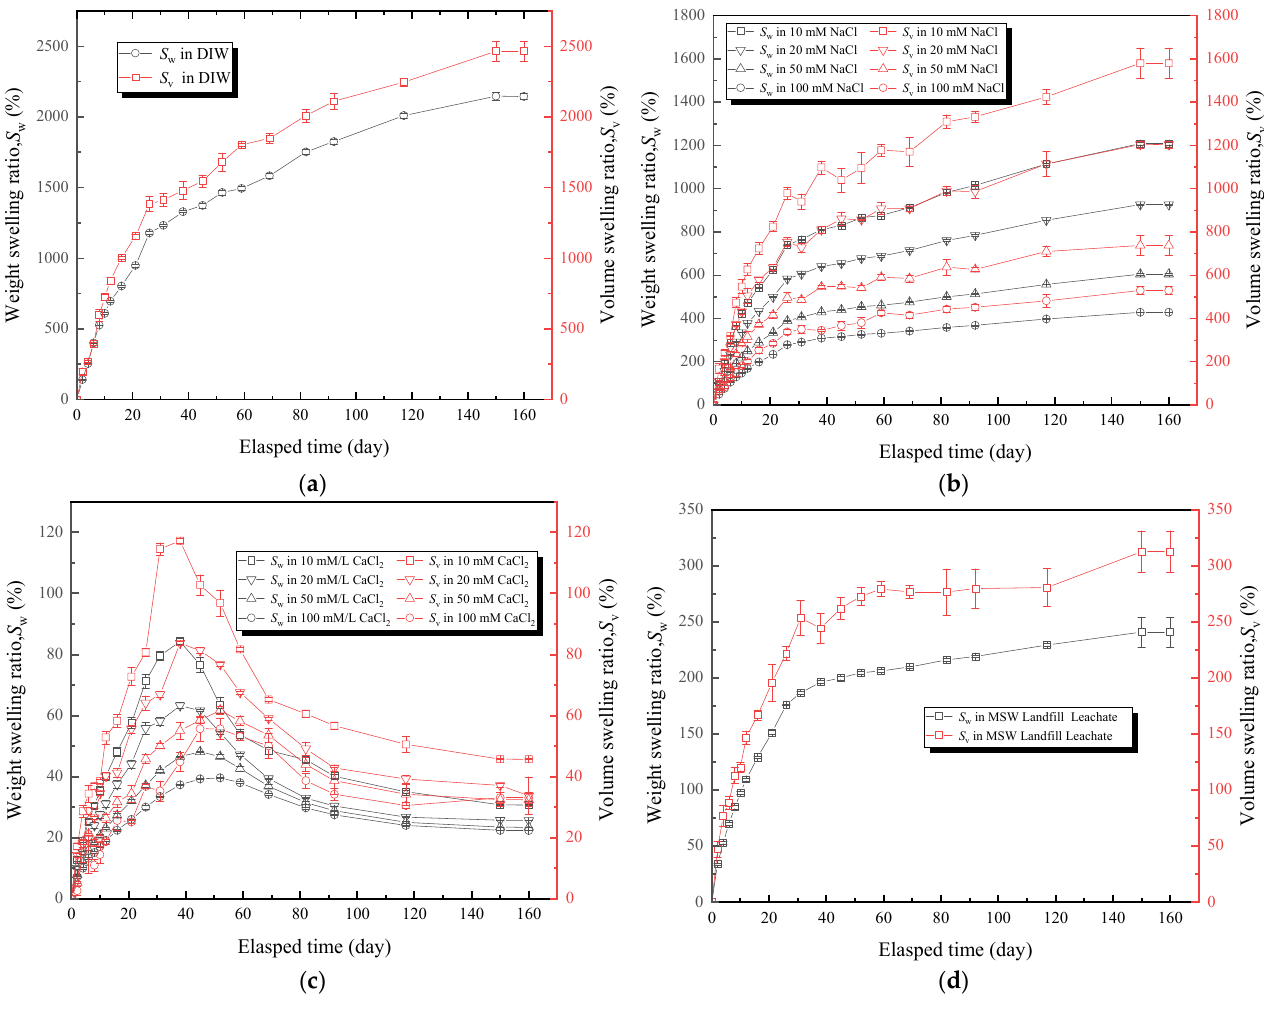
Figure 5. The effect of testing liquids: ( a ) the DIW, ( b ) NaCl solutions with different concentrations, ( c ) CaCl 2 solutions with different concentrations, and ( d ) MSW landfill leachates on free swelling ratio ( S w and S v ) of specimens.